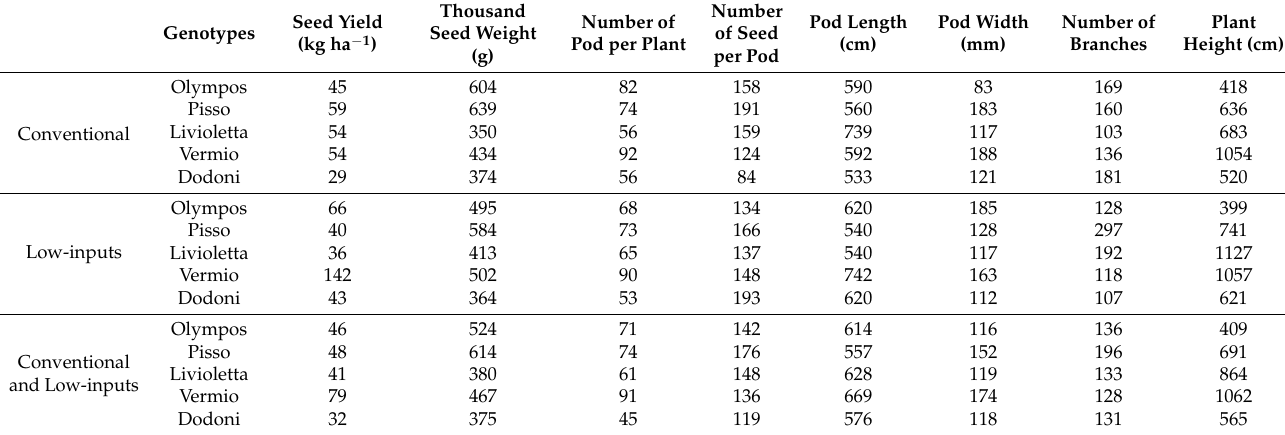
Table 3. Trait stability index across genotypes for the two farming systems: seed yield (kg ha − 1 ), thousand seed weight (g), number of pod per plant, number of seed per pod, pod length (cm), pod width (mm), number of branches and plant height (cm).